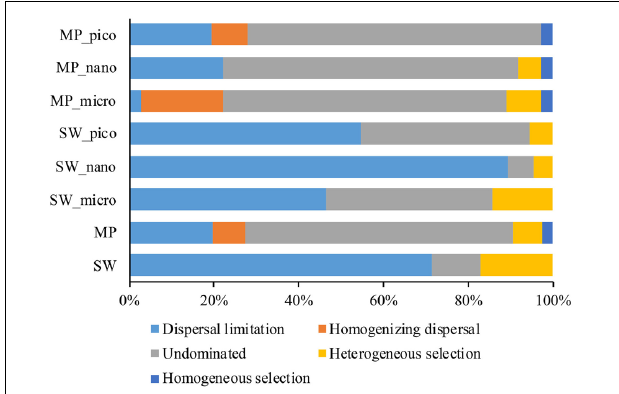
FIGURE 8 | Partition of community assembly process of microbial eukaryotes in the size-fractionated, and pooled sea water (SW), and melt pond (MP)